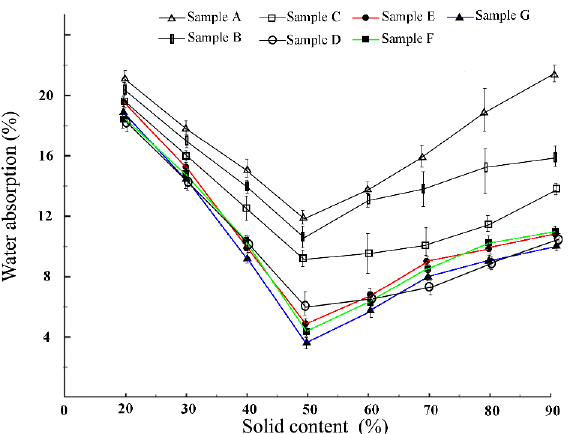
Figure 11. Effect of the ratio of anhydride to hydroxyl groups in EB on the water absorption of coatings after film formation.